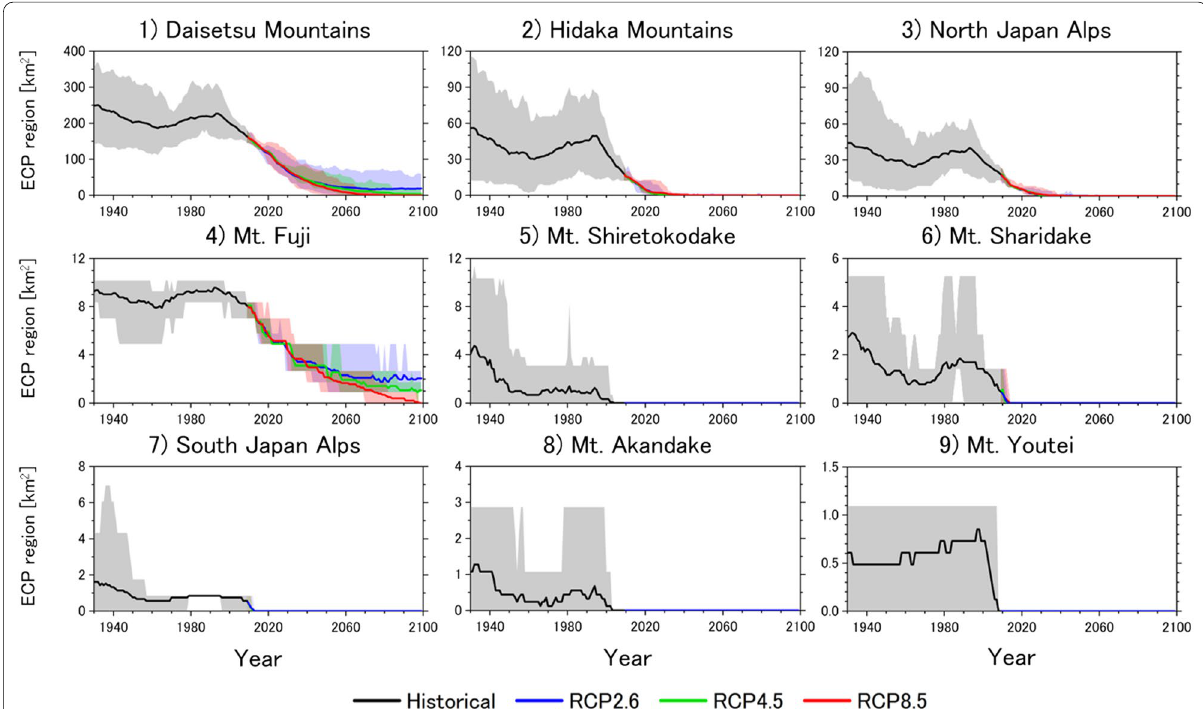
Fig. 4 Time sequence of areas in mountainous regions of Japan with surface air temperatures that favor the maintenance of permafrost; (1) Daisetsu Mountains, (2) Hidaka Mountains, (3) Northern Japan Alps, (4) Mt. Fuji, (5) Mt. Shiretokodake, (6) Mt. Shari, (7) Southern Japan Alps, (8) Mt. Akandake, (9) Mt. Yotei. Historical simulations (black) and future projections for the RCP2.6 (blue), RCP4.5 (green), and RCP8.5 (red) scenarios are shown. Shading indicates the minima and maxima of multi-model projections, and the thick line indicates the multi-model